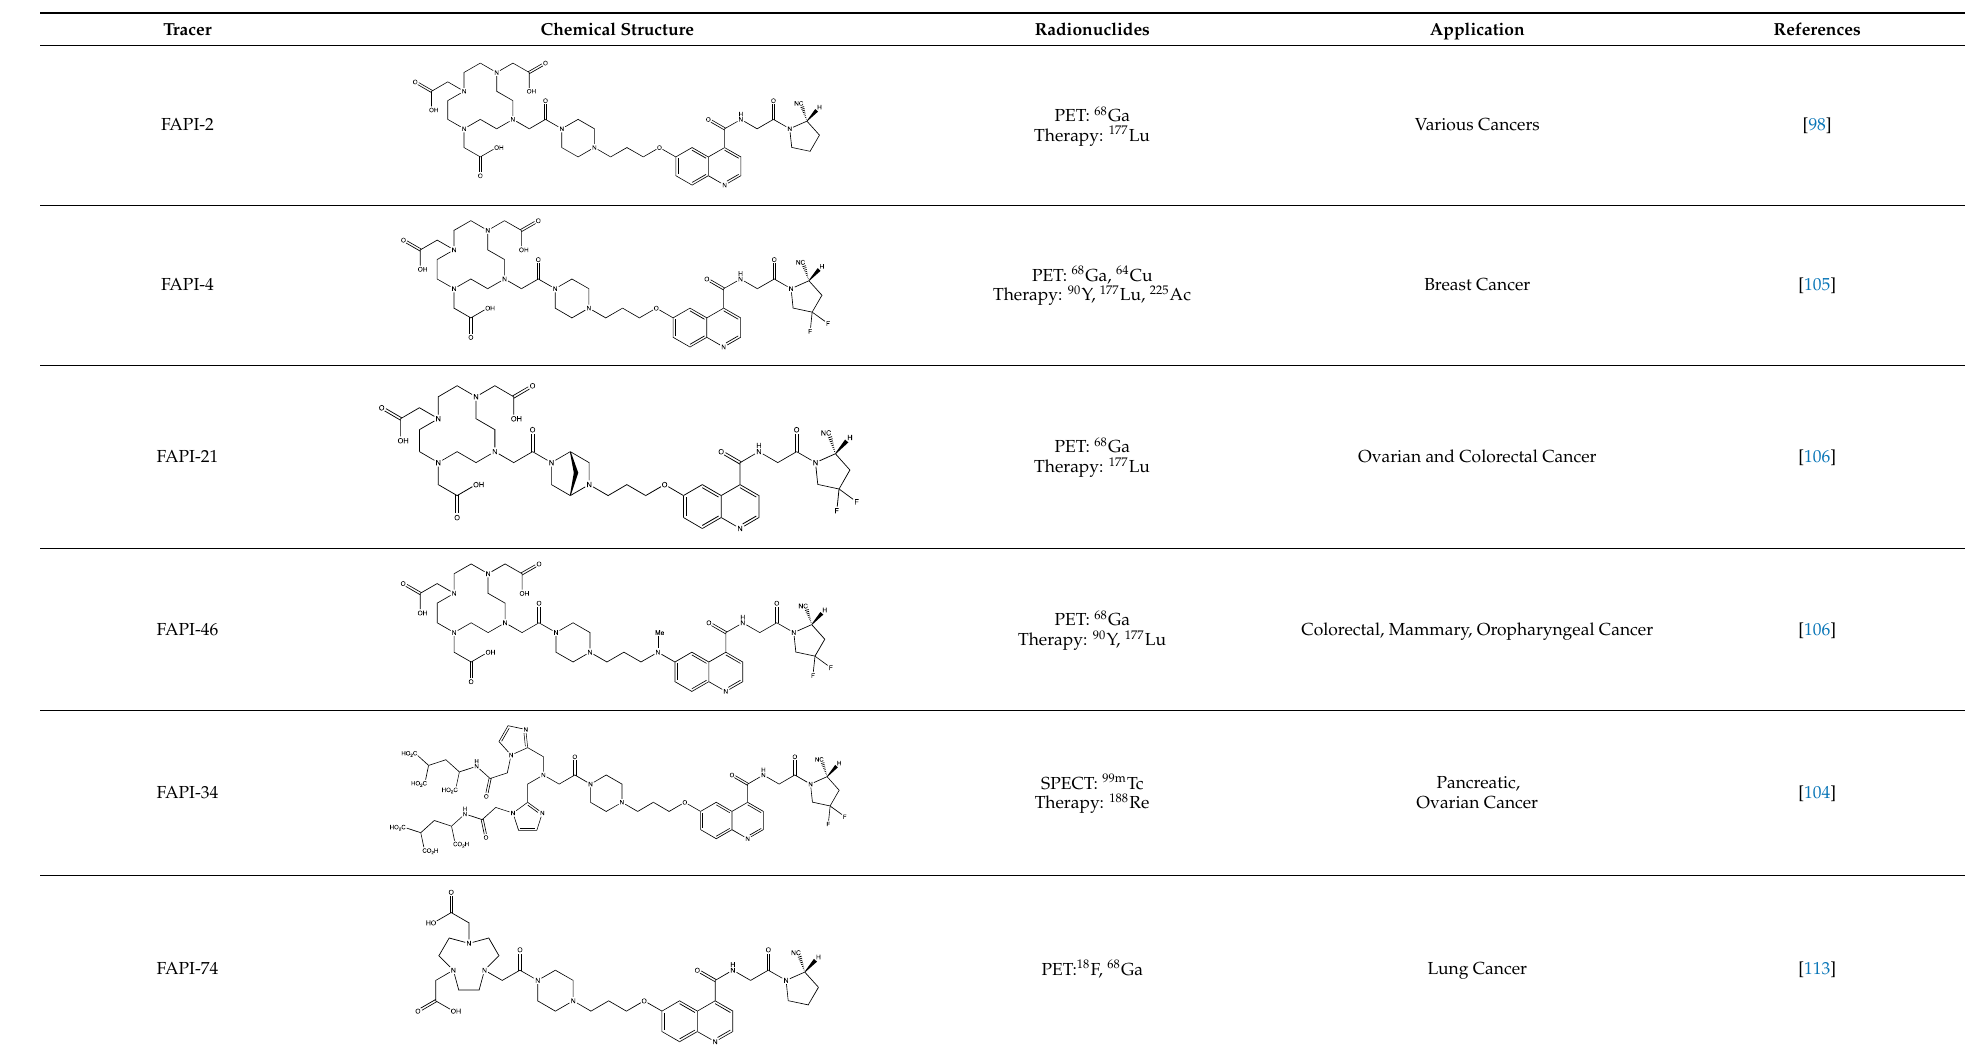
Table 1. FAP-targeting tracers used for theranostic applications.